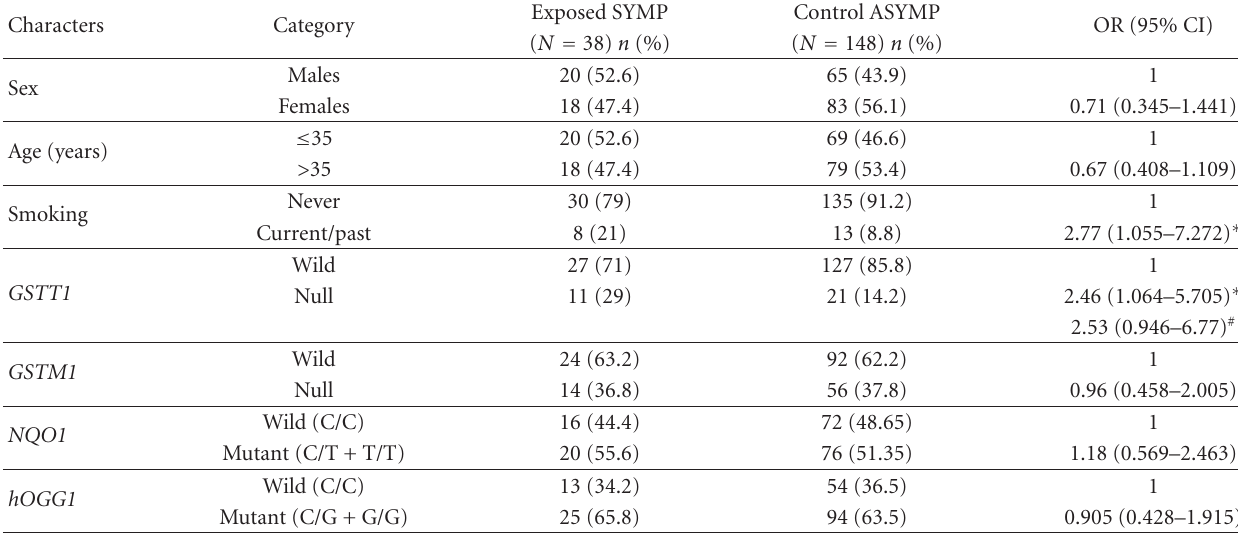
Table 4: Influence of various covariates and genotypes on dermatological adversities among exposed group compared with asymptomatic control